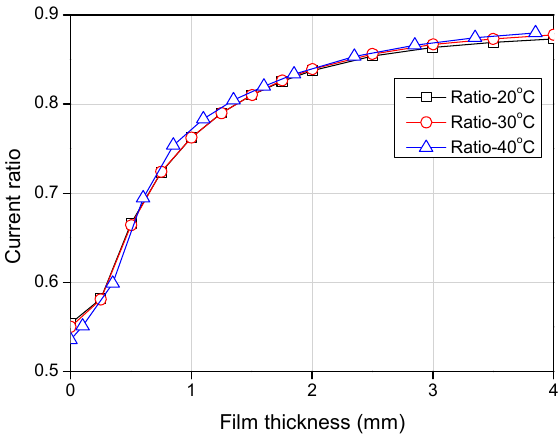
Figure 14. Current ratio with different temperature conditions.